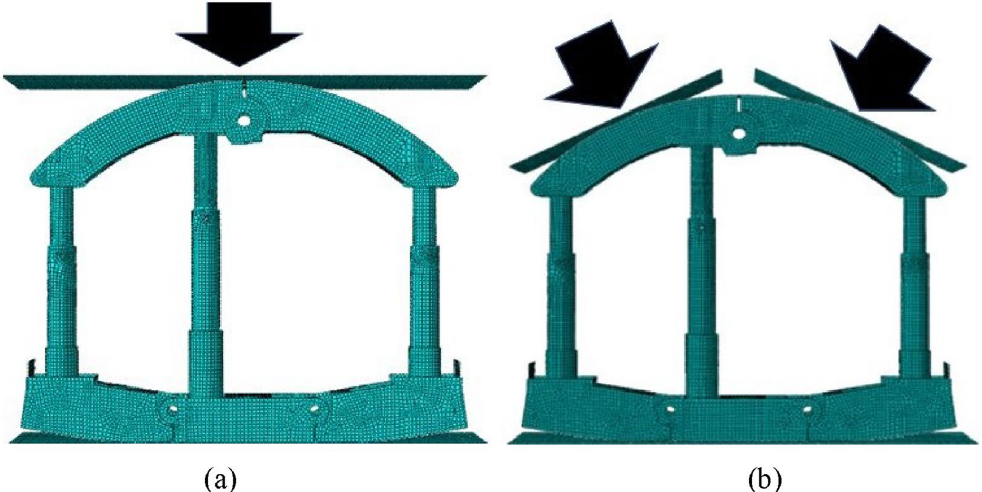
Figure 7. Energy-absorbing yielding anti-impact supporting structure under two working conditions: ( a ) Top impact condition. ( b ) Side impact condition.